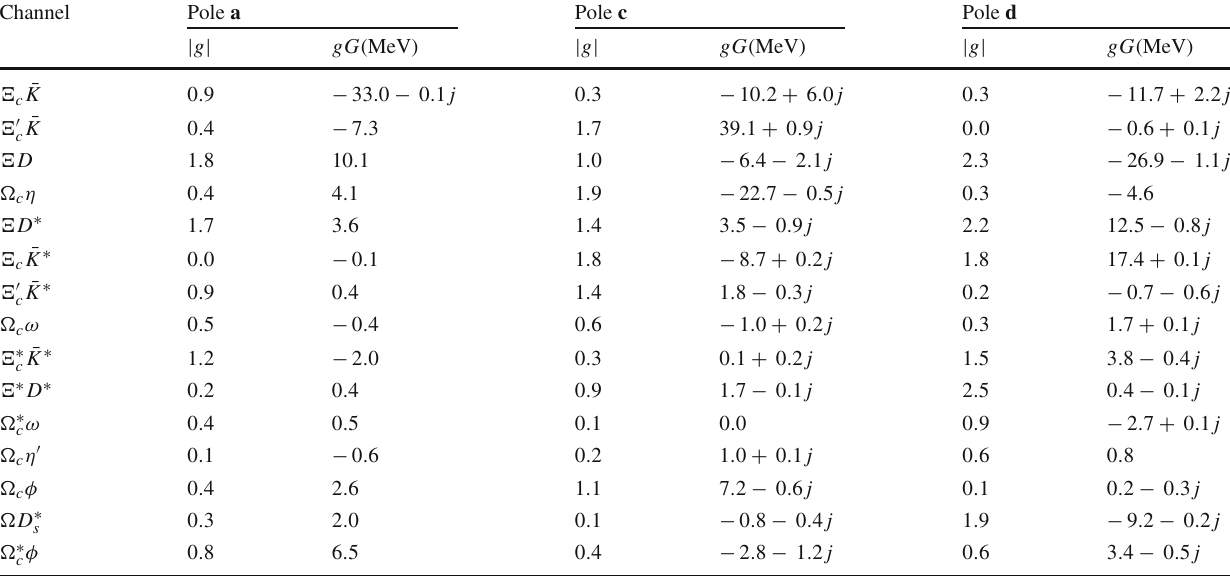
Table 5 J = 1 / 2 (cid:2) c states, labeled as poles a , c and d , calculated using the subtraction constants determined by a unique UV cutoff (cid:3) = 1090 MeV (see Eq. (13)). The first column displays the differ- ent baryon-meson coupled channels, ordered by their threshold ener- gies. The subsequent columns show the absolute value of the coupling and the product of the coupling times the loop function at the pole for